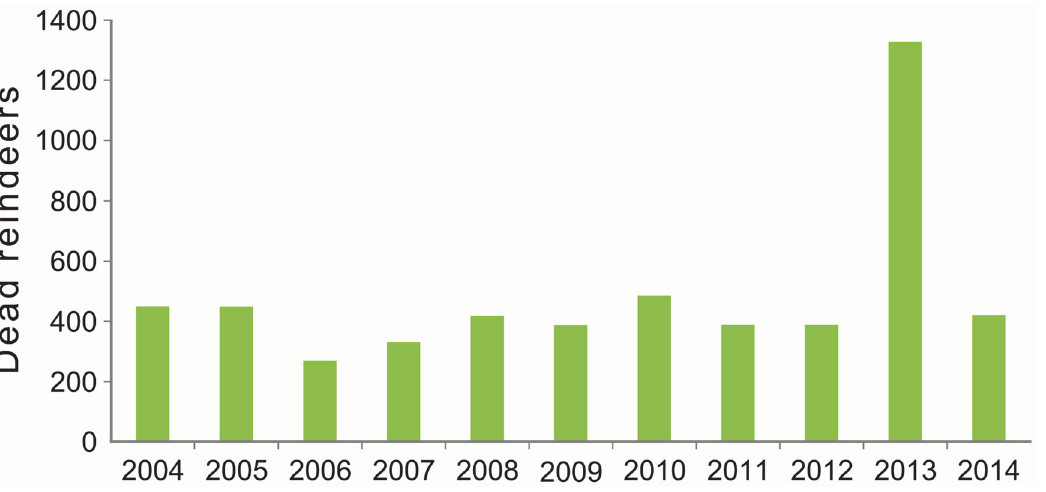
Fig 4. Number of the dead reindeers in 2004 – 2014 on Kolguev Island, Russia.